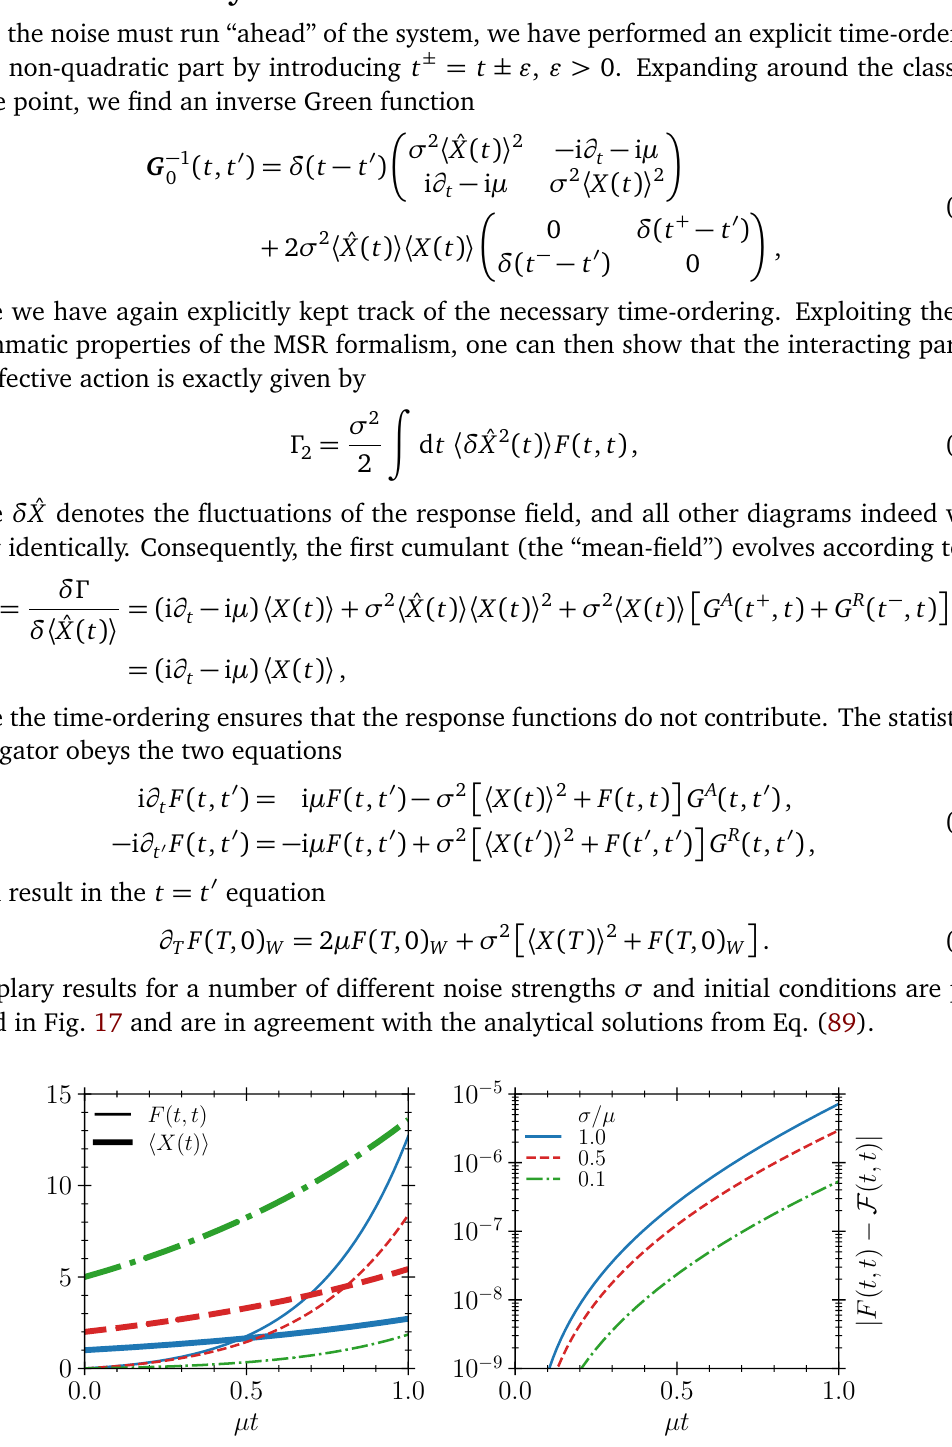
Figure 17: Numerical solution and absolute error of Eqs. (93) with rtol = 1e-7 ( t , t ) again denotes the analytical solution for the sec- and atol = 1e-9 , where F ond